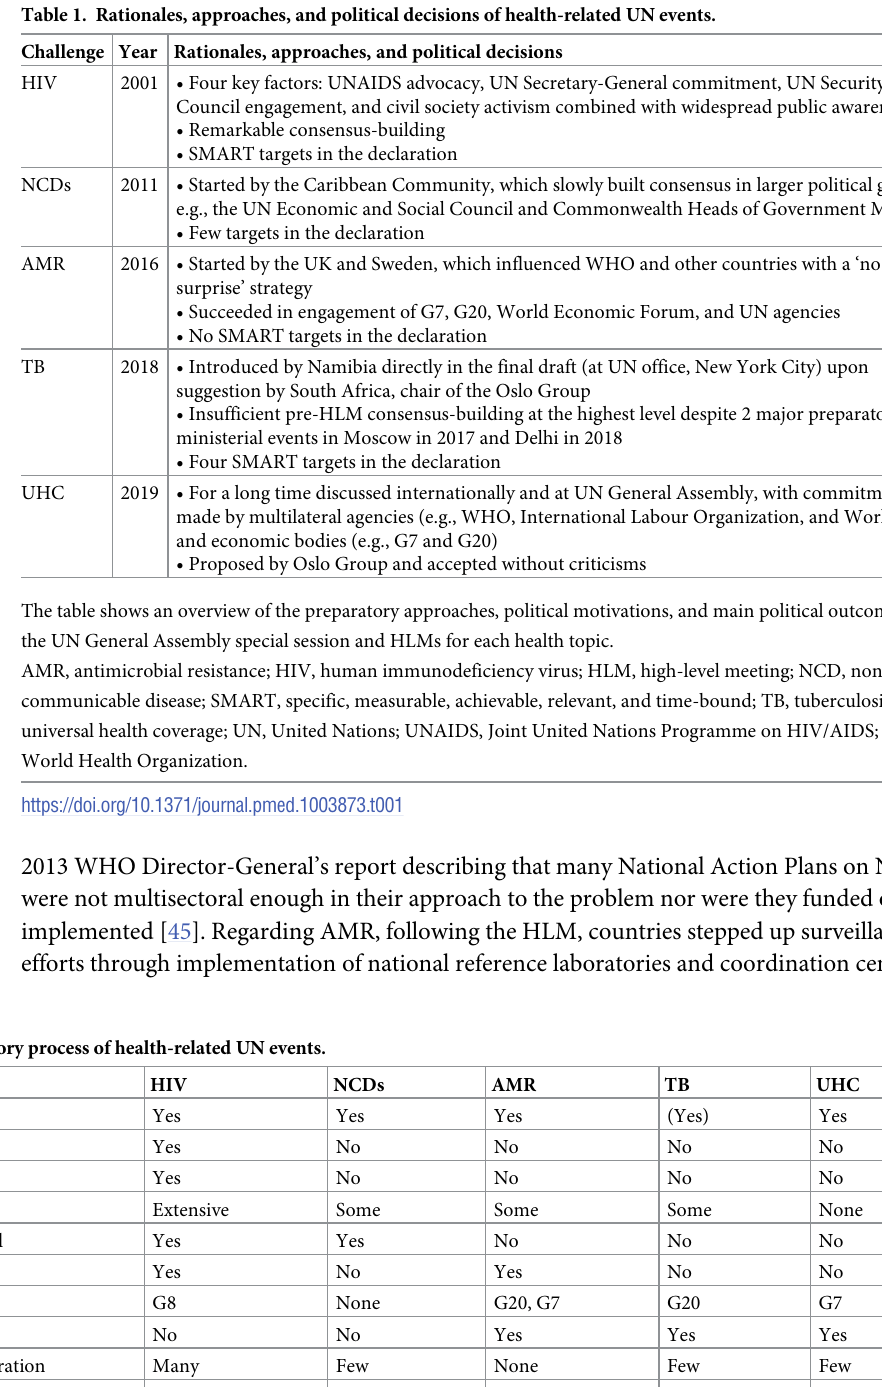
Table 1. Rationales, approaches, and political decisions of health-related UN events AU : PleasecheckthattheeditstothetitleofTable 1 captureyourmeaning : Ifnot ; pleaseprovidecorrectwording : . Challenge Year Rationales, approaches, and political decisions